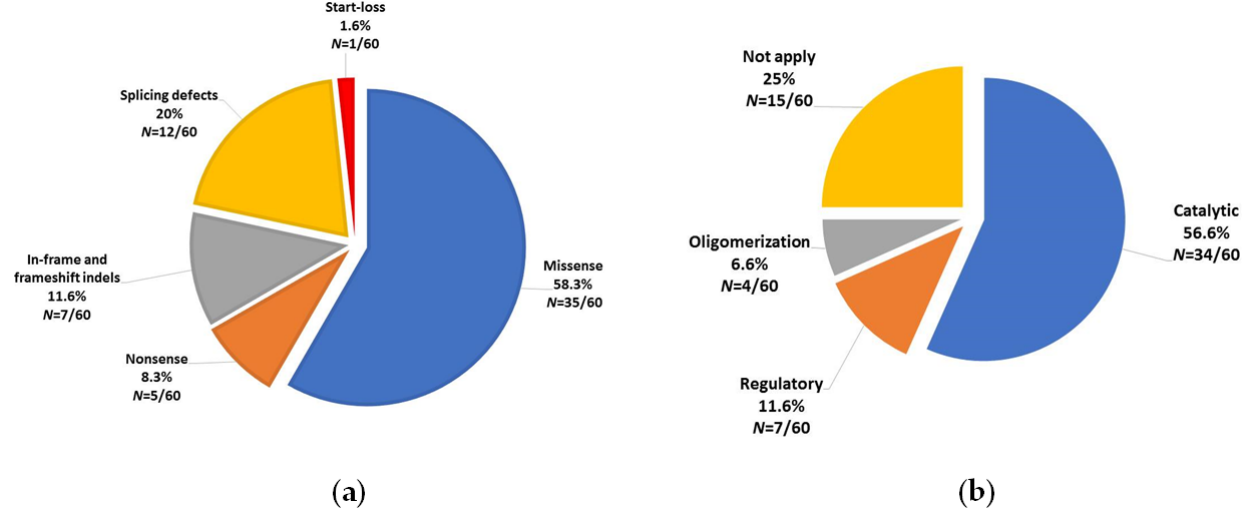
Figure 2. Main categories of the 60 types of different pathogenic variants identified among the 124 unrelated Mexican patients bearing a diagnostic biallelic PAH genotype. ( a ) Classification by predicted pathogenic effect of the variant. ( b ) Classification by affected domain. Frameshift, start-loss, splicing defects and non-sense were considered as null alleles. N= number of alleles/total of alleles (60). Table 1. Frequency and type of PAH variants found in the studied population (248 alleles) and their comparison and categorization accordingly to information available in BIOPKUdb.